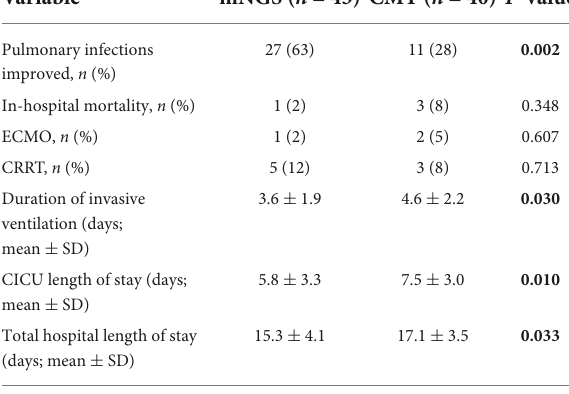
TABLE 3 Comparison of outcomes between mNGS and CMT groups a